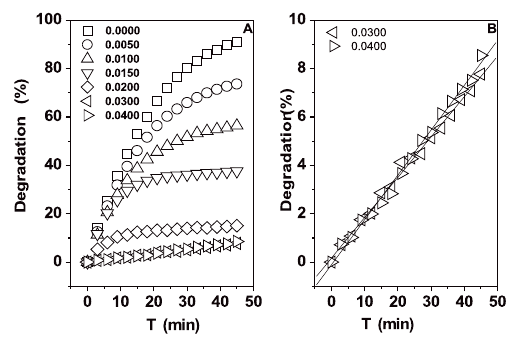
Figure 9. Variations of γ (A), η , 1- η ( Β ) of the solutions at pH 5.0 containing 0.050 mmol L -1 ACBK and Cu 2+ from 0